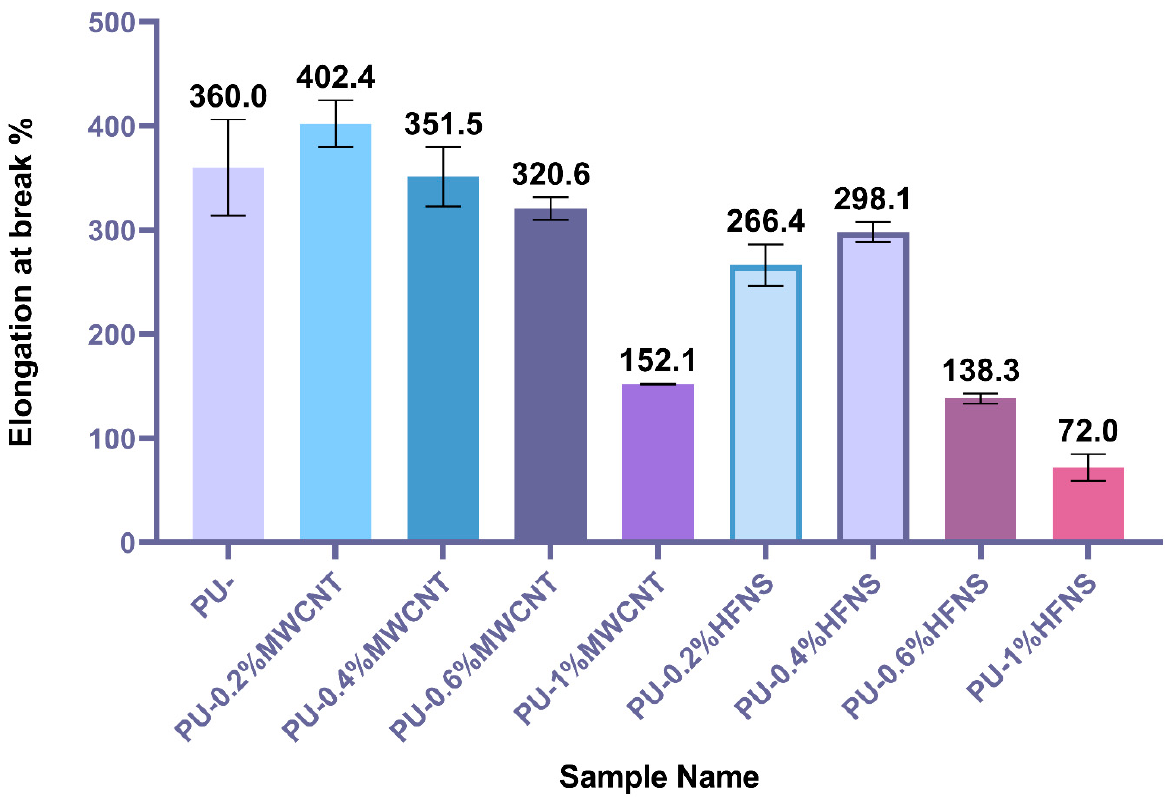
Figure 4. Elongation at break of polyurea and polyurea nanocomposites